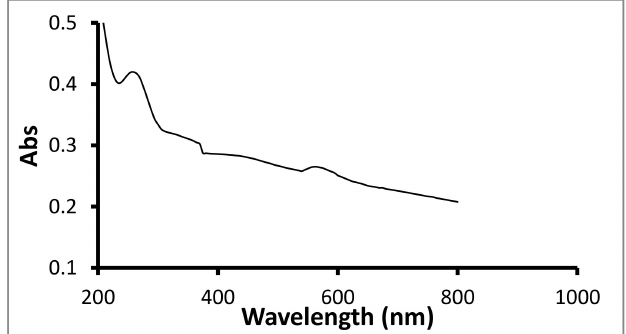
Figure 8. UV-Vis spectrum of the M. oleifera leaves extract.